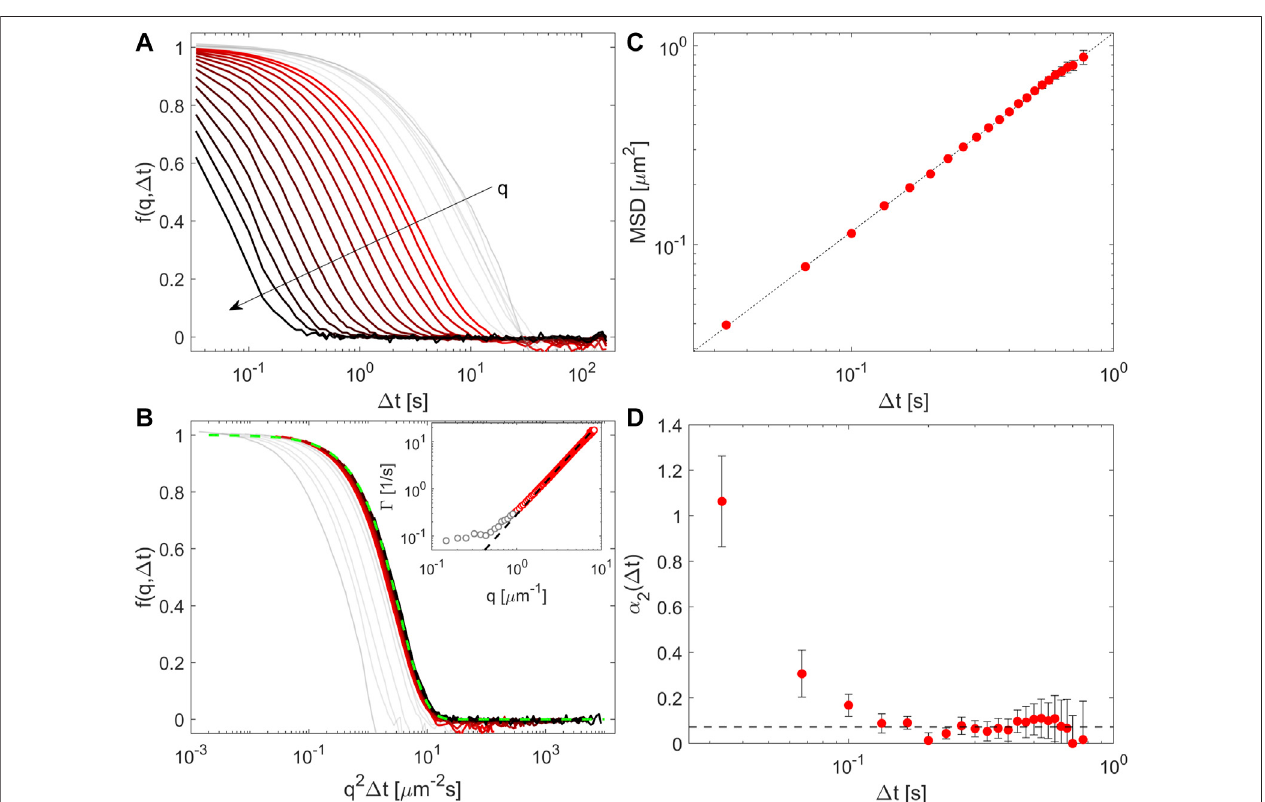
FIGURE 2 | ConDDM analysis of small non-interacting colloidal particles. (A) Representative collective ISFs. Gray lines represent ISFs for wave vectors q < q c = 0.9 μ m − 1 that we exclude from further analysis (see main text for more details); colored lines represent ISFs for different wave vectors q ranging from q c (red) to 7.5 μ m − 1 (black). (B) Same data of (A) plotted as a function of the rescaled time delay q 2 Δ t . The green dashed line is a simple exponential function e − D 0 , a q 2 Δ t with D 0,a obtained by fi tting an homogenous quadratic function D 0,a q 2 to the relaxation rate Γ ( q ) (inset) for q > q l (black dashed line). Γ ( q ) is estimated by fi tting an exponential model e − Γ ( q ) Δ t to the ISFs shown in panel (A) . (C) Mean square displacement MSD ( Δ t ) and (D) non-Gaussian parameter α 2 ( Δ t ) extracted from the ISFs in the low wave-vector limit along with the condition q > q c . The black dotted line in (C) is the best fi tting curve to the MSD with a linear model MSD ( Δ t ) = 4 D 0,b Δ t , whereas the one in (D) corresponds to the mean value α 2 ( Δ t ) ≃ 0 . 08.